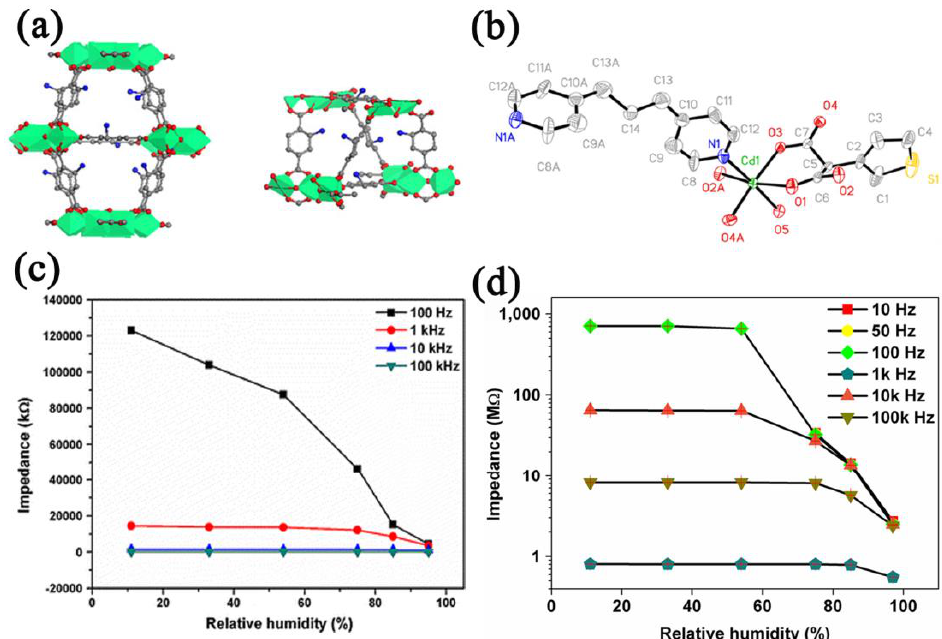
Figure 4. ( a ) Crystal structure of NH 2 − MIL − 125(Ti). Reproduced with permission from Ref. [77]. Copyright 2013, Springer Nature. ( b ) Coordination environment of [Cd(TMA)(DPP) 0 . 5 ∙H 2 O] n . Reproduced with permission from Ref. [78]. Copyright 2018, Elsevier B.V. ( c ) Response curves vs. frequencies of NH 2 − MIL − 125(Ti) − based humidity sensor in the humidity range of 11–95% RH. Reproduced with permission from Ref. [77]. Copyright 2013, Springer Nature. ( d ) Response curves vs. frequencies of [Cd(TMA)(DPP) 0 . 5 ∙H 2 O] n − based humidity sensor in the humidity range of 11 – 95% RH. Reproduced with permission from Ref. [78]. Copyright 2018, Elsevier.